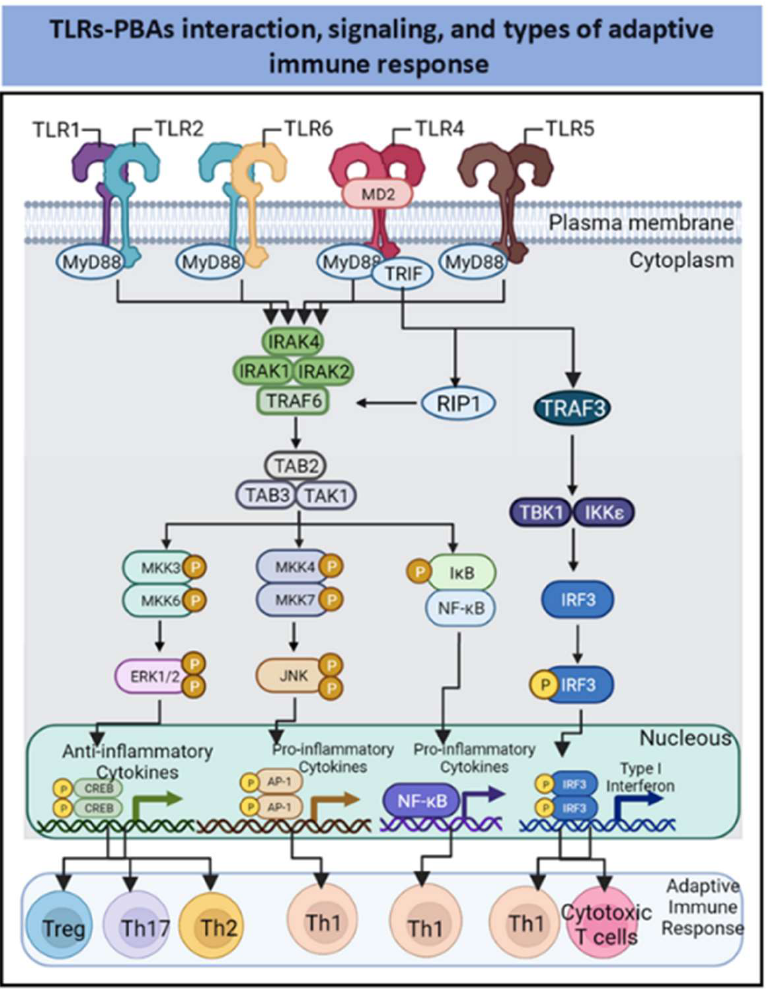
Figure 1. Molecular targets of TLR-PBAs and downstream signaling leading to different types of immune responses . The PBAs interact at the cell surface of APCs with TLR2 (e.g., porins FomA and MOMP, AB-type toxins and OMP 16); TLR4 (e.g., HMGB1, heat-shock-70-like protein 1, and SIP), pneumolysin, hemocyanin ML-I); TLR5 (e.g., flagellin); and heterodimers TLR2–TLR1 (e.g., porin OmpU) or TLR2–TLR6 (e.g., porin MOMP). The TLR signaling is initiated by the dimerization of